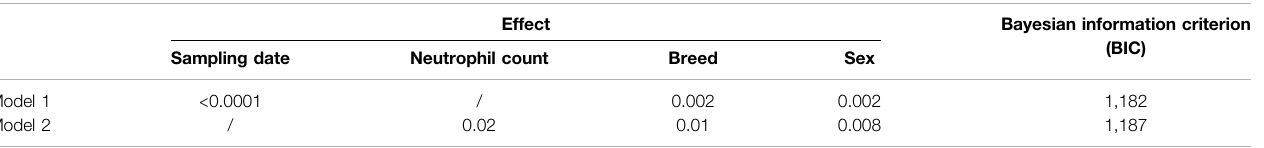
Fifteen Blackbelly and 15 Romane lambs (representing 16 males and 14 females) were slaughtered at around 5 months of age to sample tissues. Samples of 13 different tissues (including a blood sample) were collected from both males and females. Three